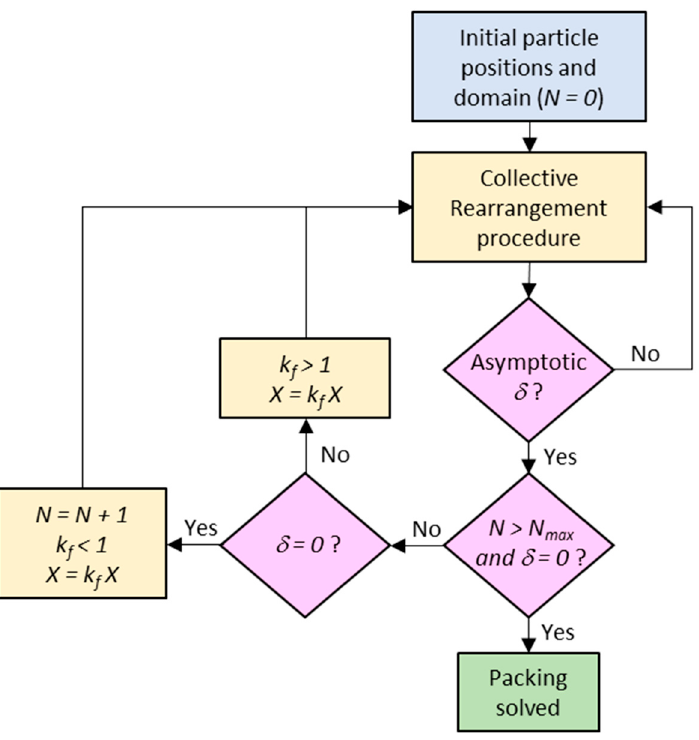
Figure 3. Flowchart of the packing algorithm.